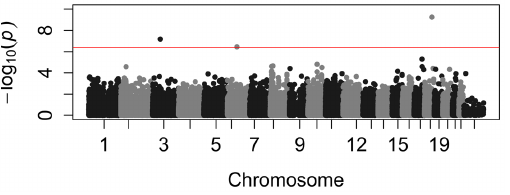
Figure 1. Manhattan plot of genome-wide association study of decline of eGFR. SNPs were characterized using the Illumina Cardio-Metabo Chip. After frequency and genotyping pruning, there were 124215 SNPs left. Highest association was seen in rs17069906 (p 5 5.63 e-10), rs9812824 (p 5 6.53 e-8), and rs9588431 (p 5 3.57 e-7).The red line indicates genome-wide significant associations (4.02 e-7).SNPs are associated with decline of eGFR independently from baseline